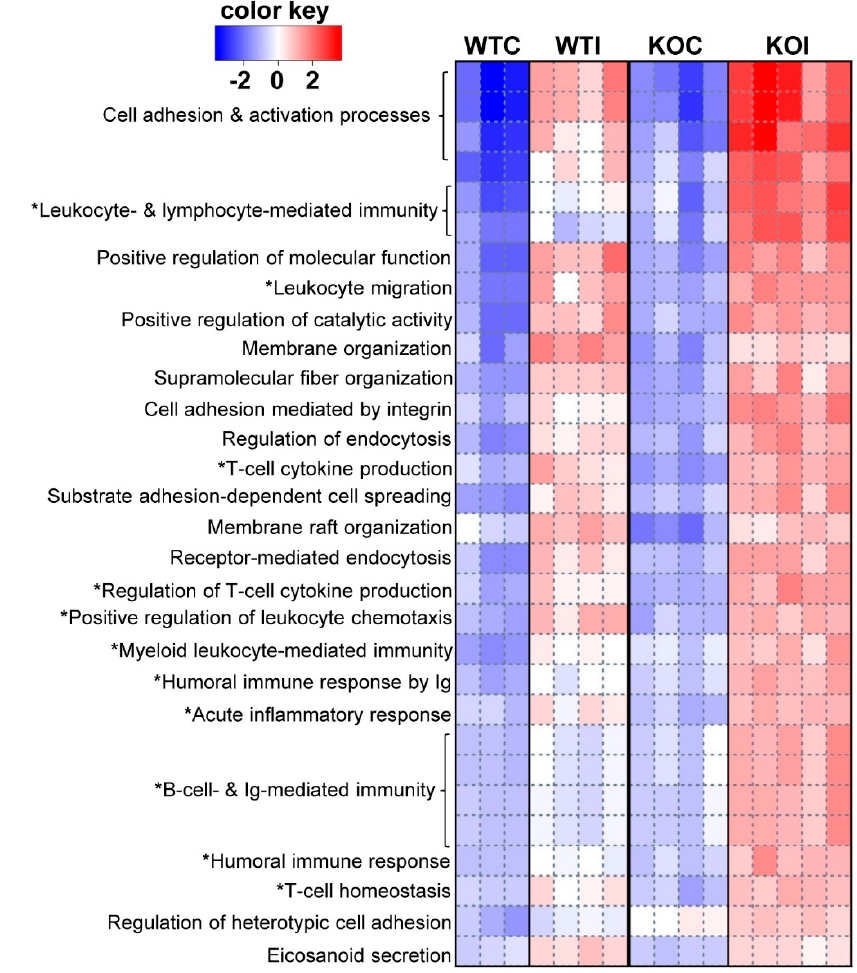
Figure 5. Pathway analysis of genes (mRNAs) that respond differentially to iodide among Nrf2 KO and WT mice using Parametric Gene Set Enrichment Analysis (PGSEA). The heatmap depicts the trend for each Gene Ontology (GO) biological process for each sample. Red squares indicate upregulation (positive z -score), while blue squares indicate downregulation (negative z -score). GO terms marked with an asterisk (*) refer to processes relevant to inflammation / autoimmunity. The top 30 pathways are shown, with FDR set at < 0.05. Table S5 (Supplementary Materials) shows the z -score values for each pathway per sample and the respective p -values for each pathway.